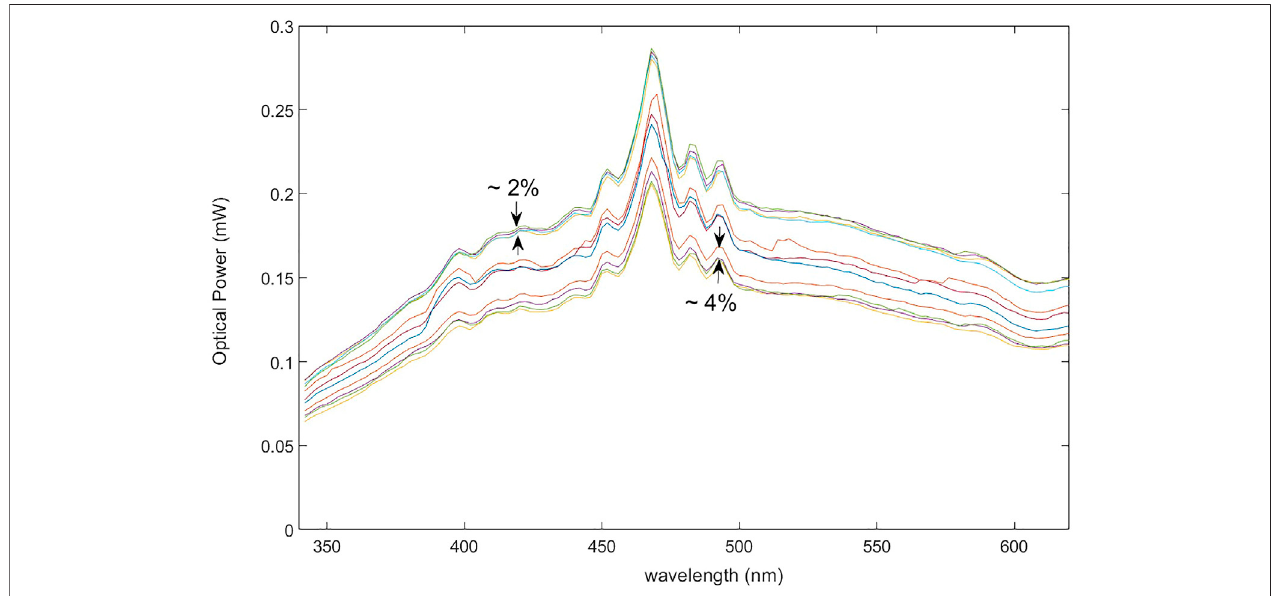
FIGURE6| SeriesofmonochromatorscansofaXelampoveraperiodof6 h.Sometypicalshifts,duringtheperiodsofrelativestabilitybetweenthelargerjumpsof intensity, are indicated as a percent error.